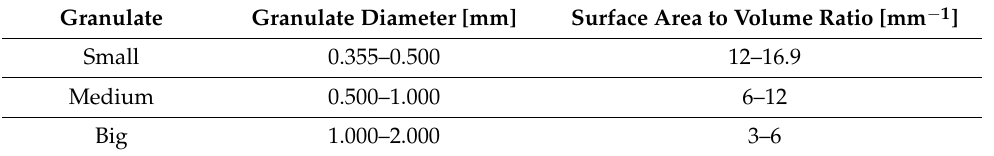
Table 1. Overview of the granulate